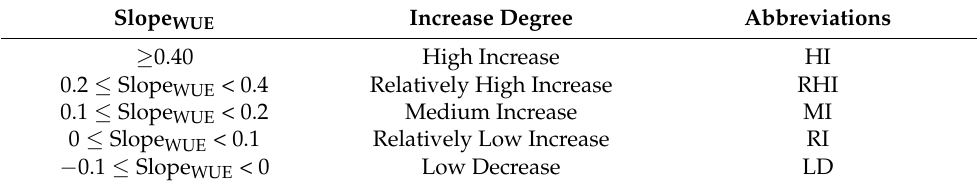
Table 1. Scale of trend